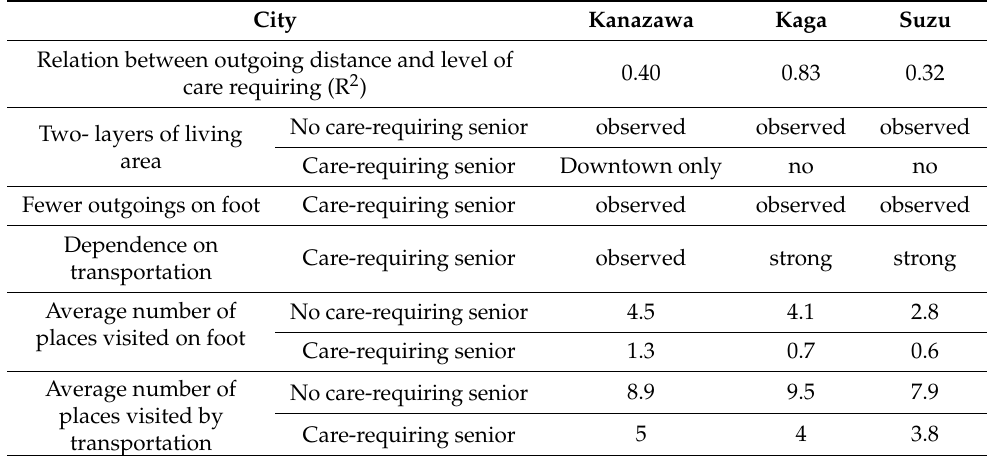
Table 4. Factor comparison of three target